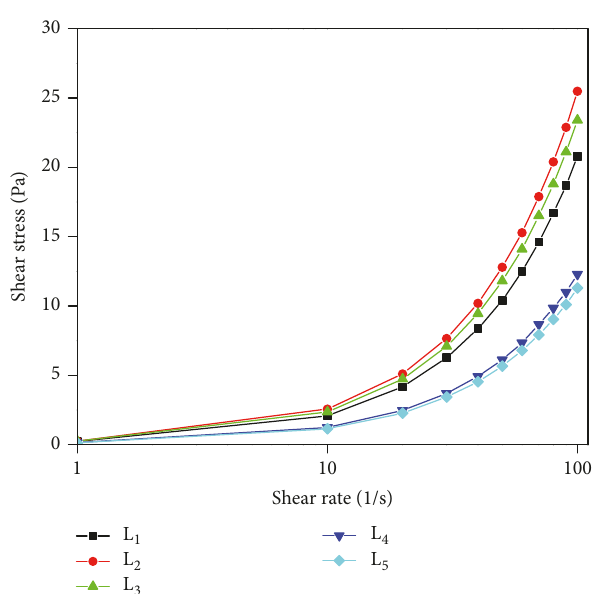
Figure 4: Variation of shear stress with shear rate for the lubricants.